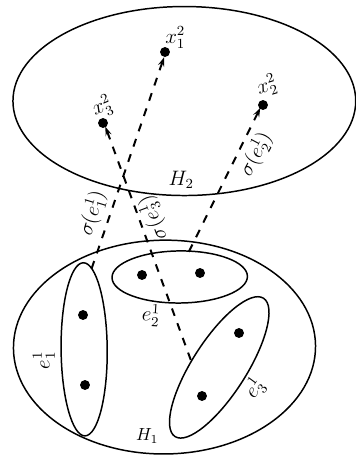
Figure 13. The zoom-out